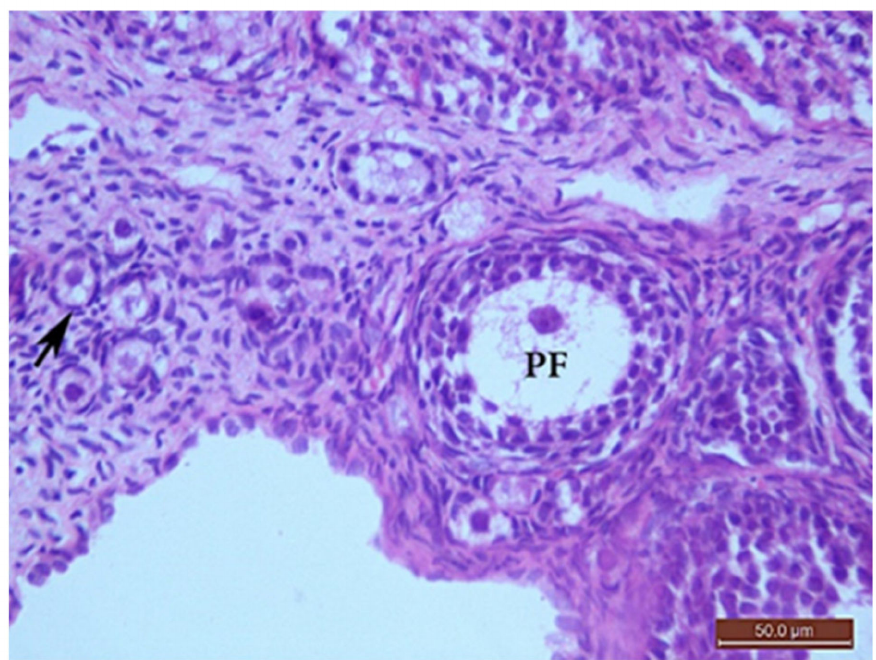
Figure 2. H&E × 400 Photomicrograph from G I ovary. Ovarian section from G I rat at x400 magnification showing a primordial follicle (arrow) with a small, rounded oocyte with obvious nucleus, surrounded by flat stromal cells. The primary follicle (PF) had a bigger oocyte surrounded by one layer of cuboidal cells, one or two layers of granulosa cells and outer flat stromal cells.